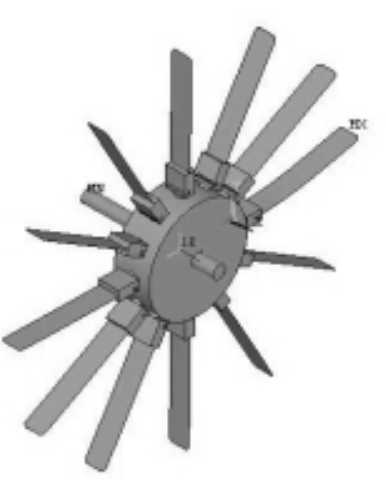
Fig. 3. Mode shape at 51.778 Hz of natural frequency (no